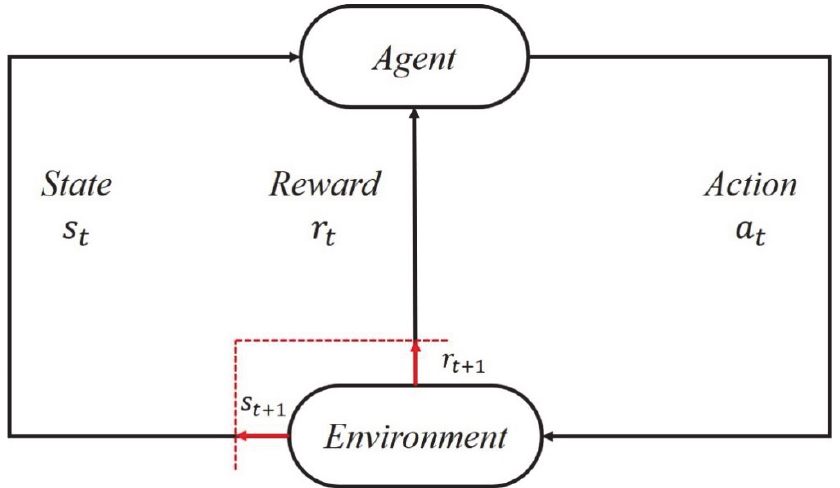
Figure 1. The framework of reinforcement learning.